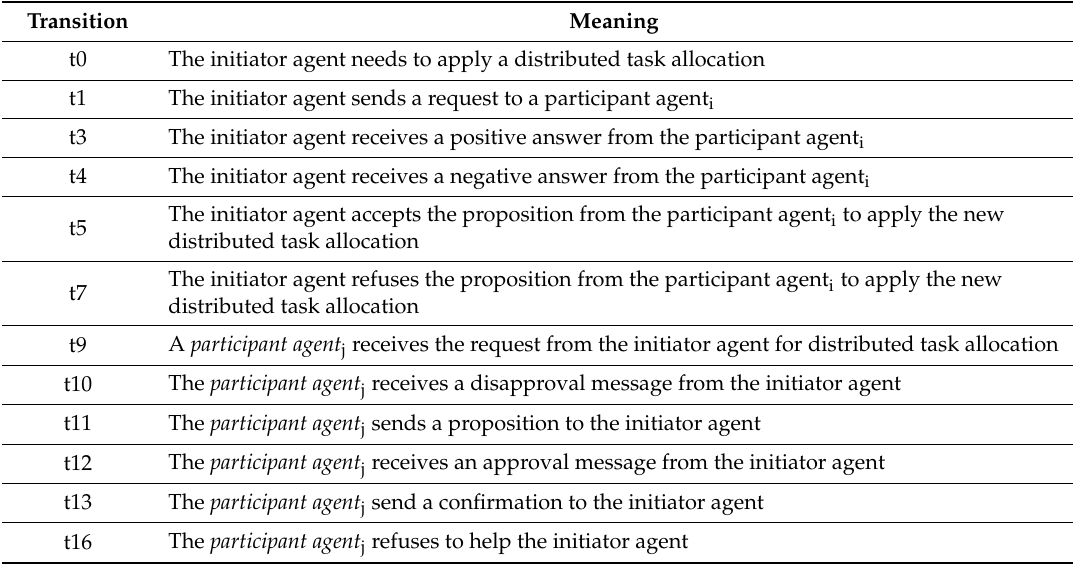
Table 1. The meaning of the main transitions related to Figure